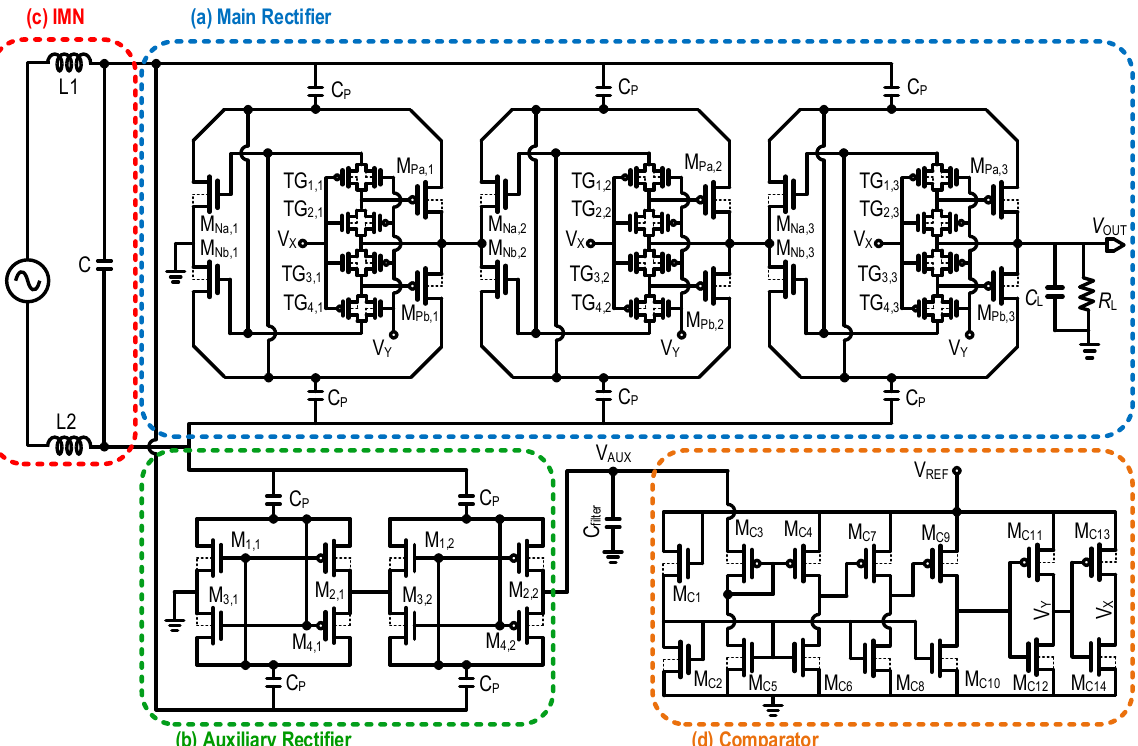
Figure 5. The schematic of the proposed reconfigurable hybrid rectifier with ( a ) main rectifier, ( b ) auxiliary rectifier, ( c ) impedance matching network (IMN), and ( d ) comparator. the diodes, the proposed scheme balances forward conduction and controls reverse